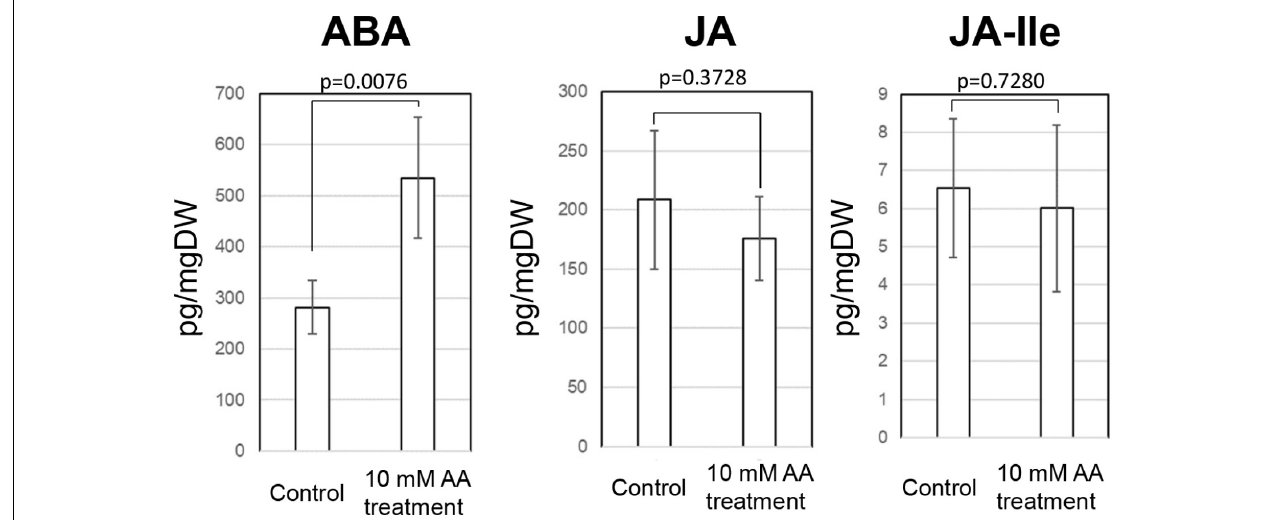
FIGURE 5 | ABA, JA, and JA-Ile contents in the cassava leaves at 7 days after external application of acetic acid and water (control). A p -value on figure was measured by paired t -test.